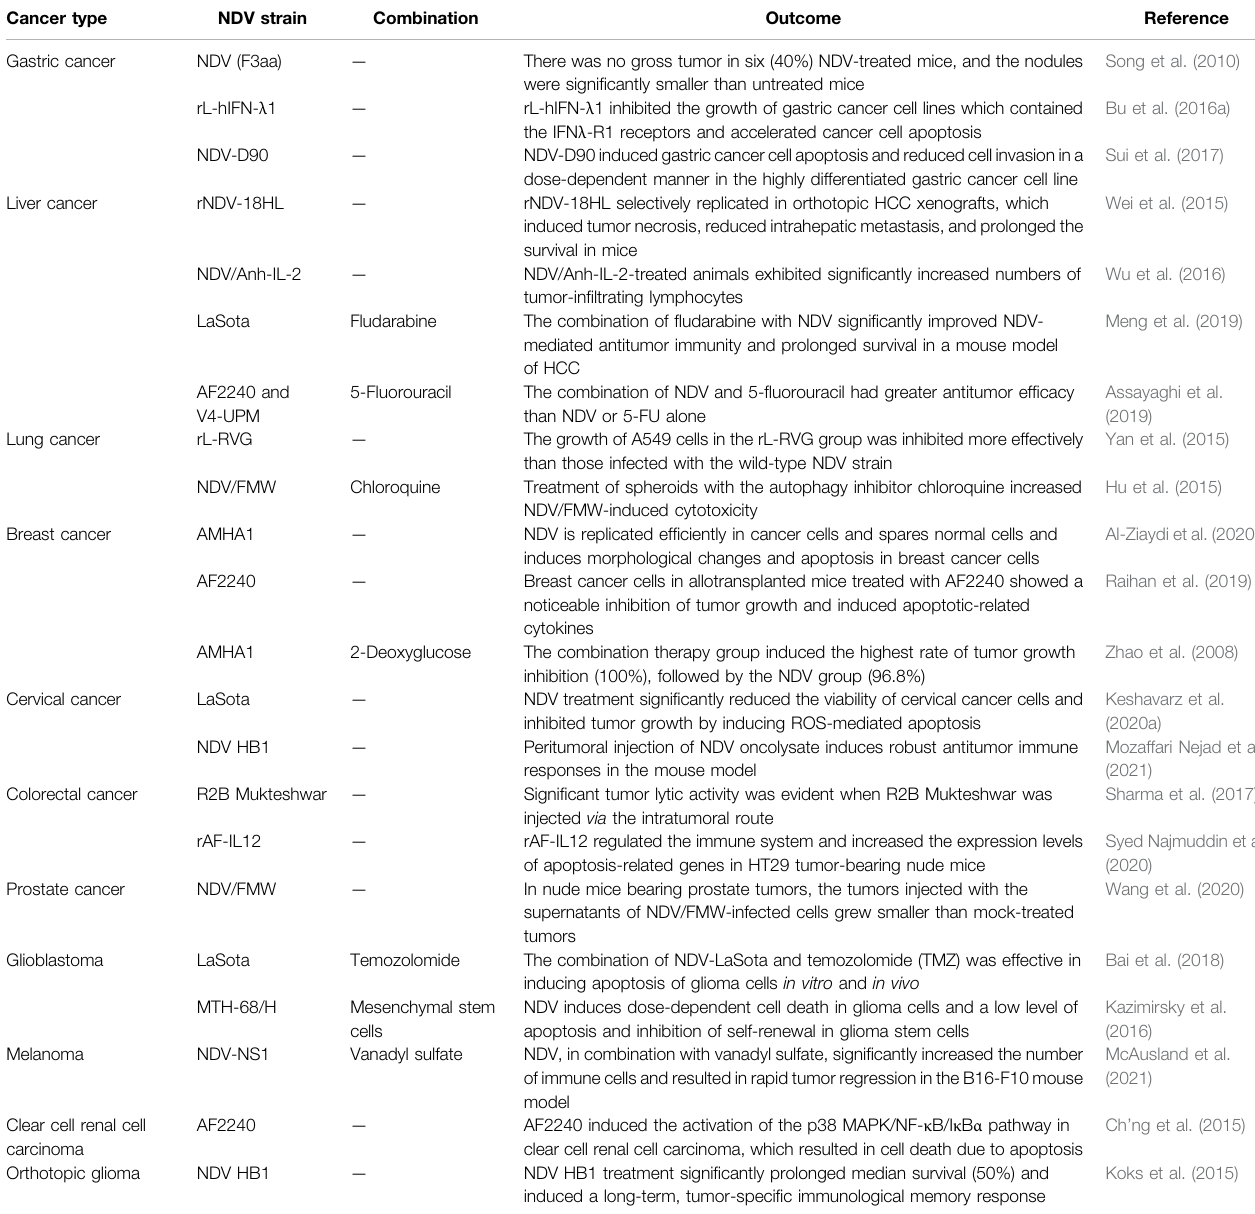
TABLE 1 | NDV strains in the treatment of different cancers in preclinical